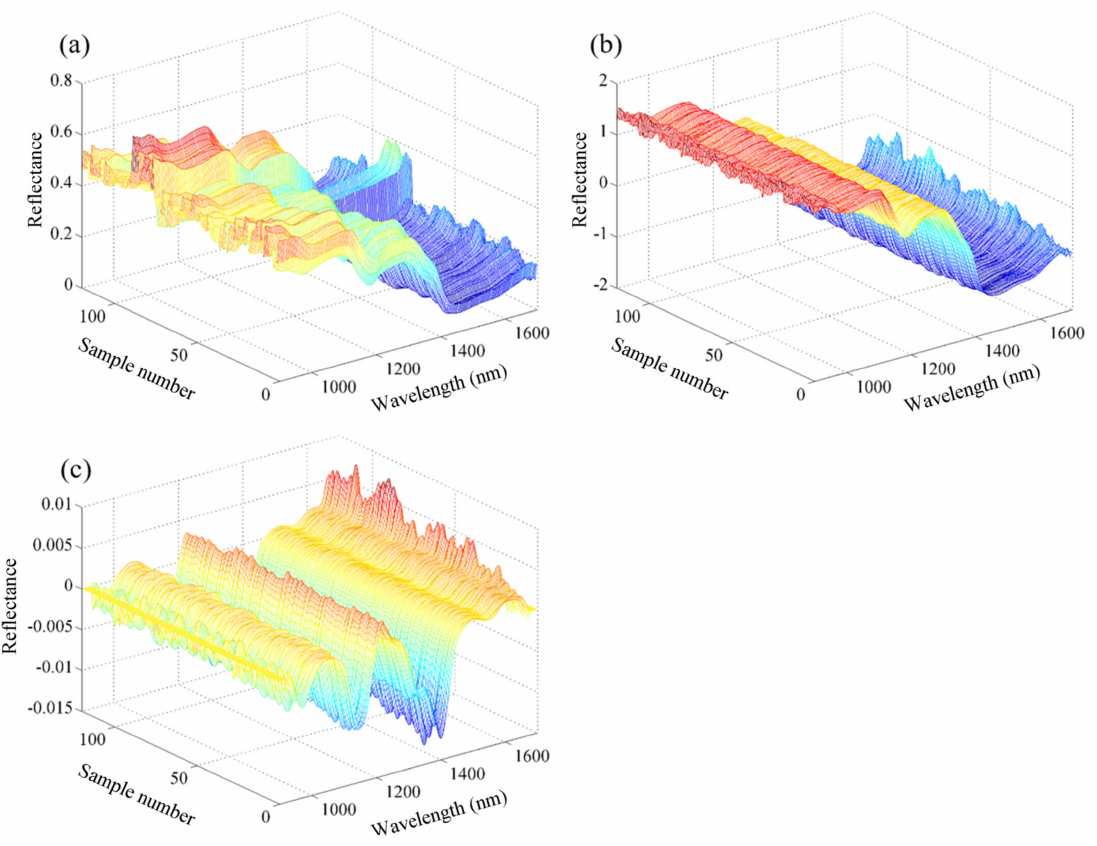
Figure 2. Spectral curves of all millet samples by using ( a ) raw data; ( b ) SNV preprocessed data; and ( c ) 1D preprocessed